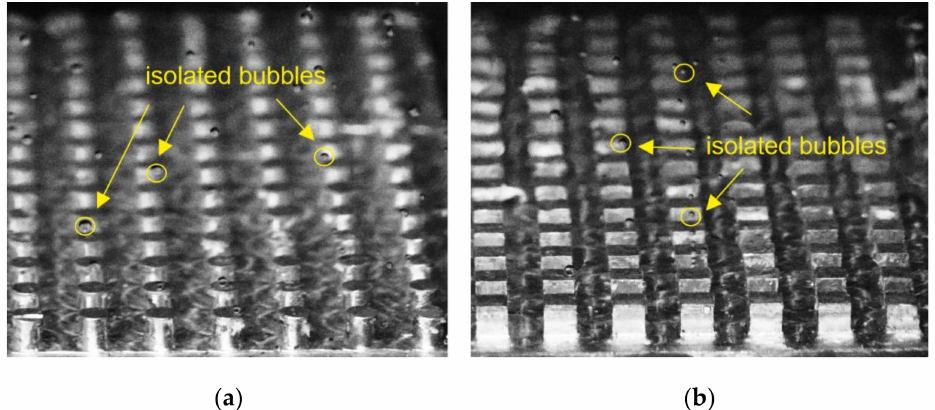
Figure 6. Phenomenon of isolated bubble regime observed from: ( a ) 1 mm gap circular pin fin array at q” = 14.5 W/cm 2 ; ( b ) 1 mm gap rectangular pin fin array at q” = 13.0 W/cm 2 .